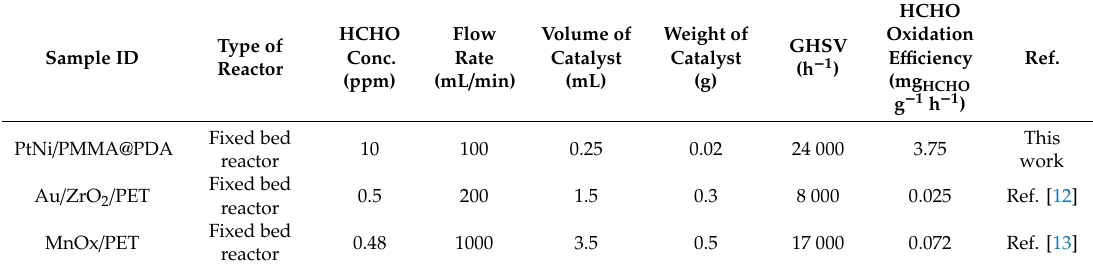
Figure 6. The air resistance of the fibrous membrane and the commercial Al 2 O 3 with different pellet sizes as a function of the gas flowing speed. Table 3. Comparison of the HCHO oxidation efficiency over the catalyst per gram per hour.